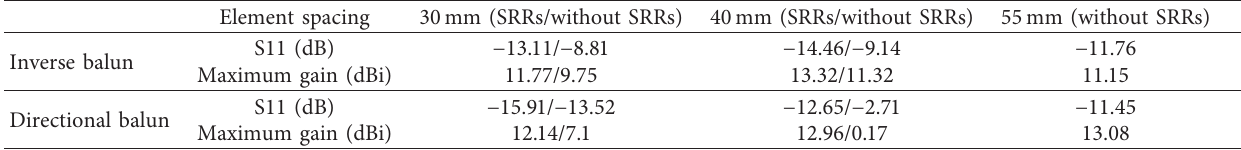
e ). (a) Inverse balun. (b) Directional balun.